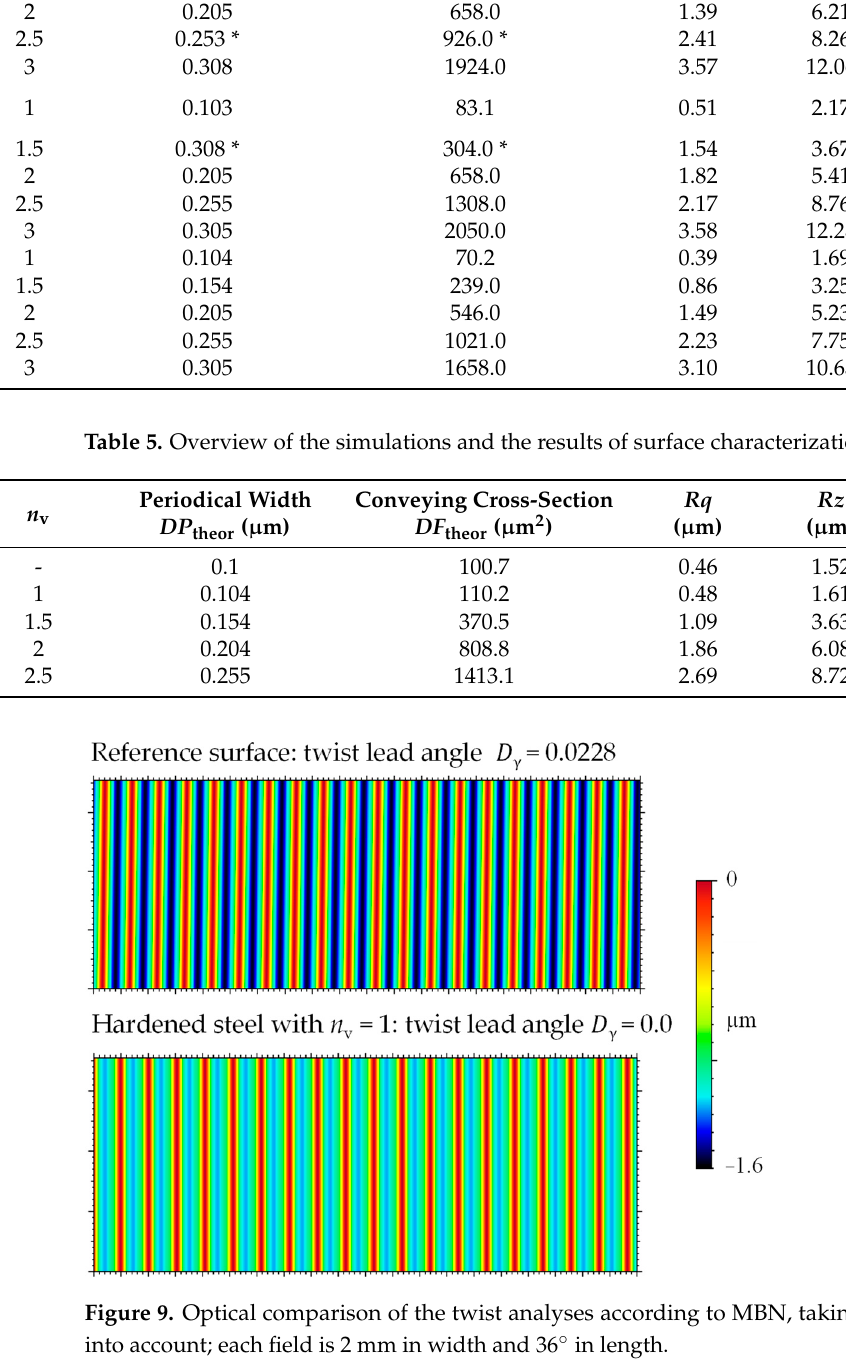
Table 5. Overview of the simulations and the results of surface characterization.